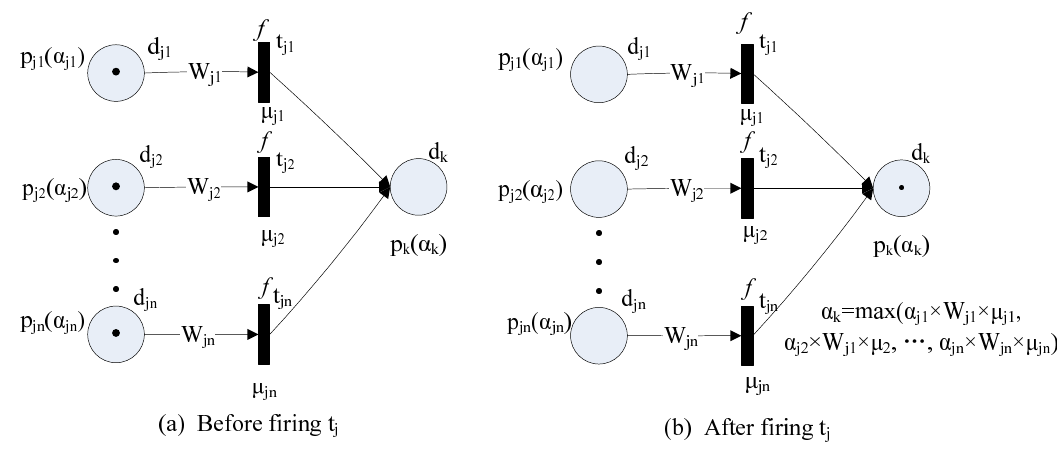
Figure 4. Fuzzy Petri nets representation of type 3